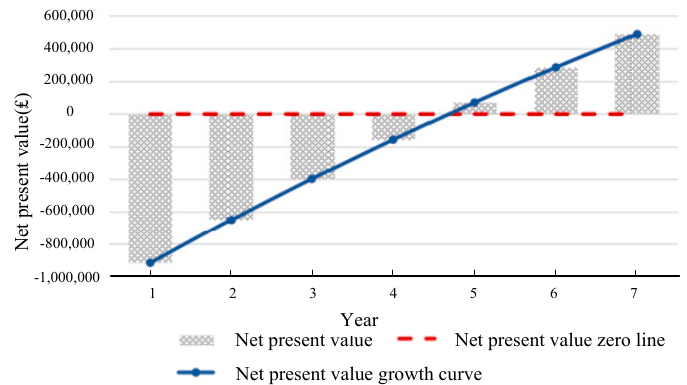
Figure 4. Net present value of the ESD in its life cycle.